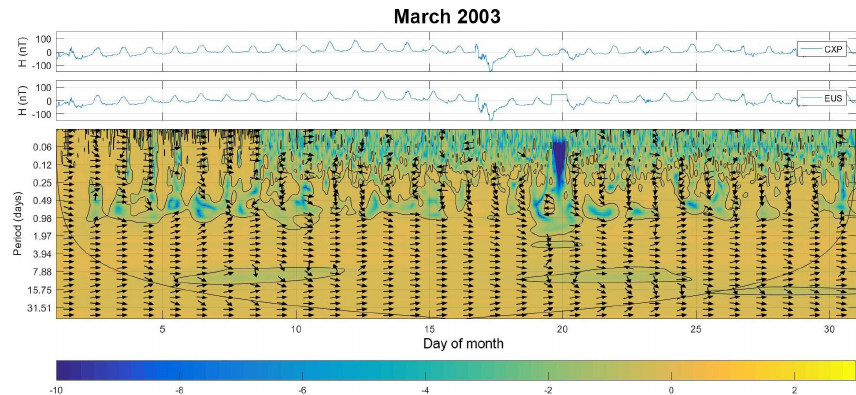
Figure 4. (a) Monthly time series of the H component from the geomagnetic field of the CXP and EUS, Brazil; (b) phase coherence applied in the same time series. Arrows indicate the phase difference between the time series of the wavelet spectra where right arrows indicate series are in phase, left arrows indicate series are completely out of phase (180 ◦ ), and an arrow pointing vertically means the second series lags the first by 90 ◦ .